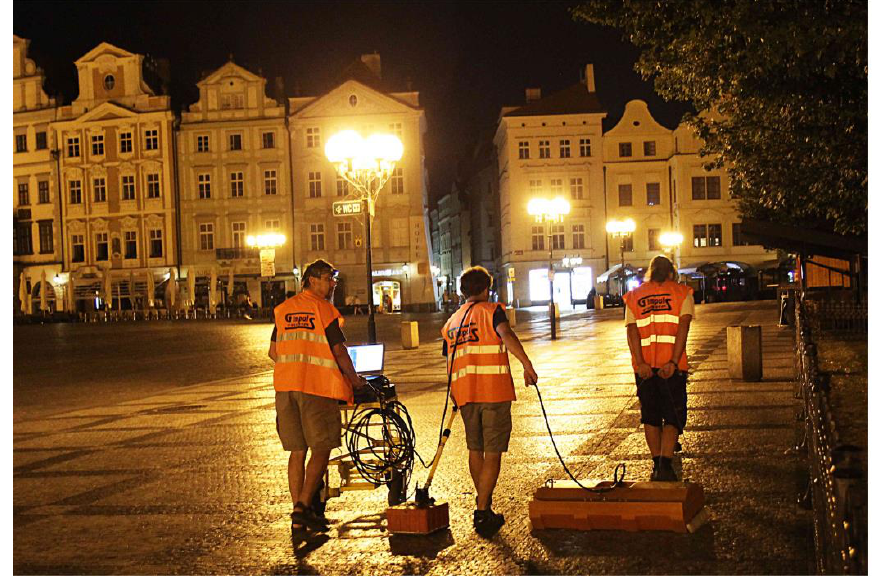
Figure 12. Old Town Square. Geological radar SIR 20 with 400- and 100-MHz antenna systems.